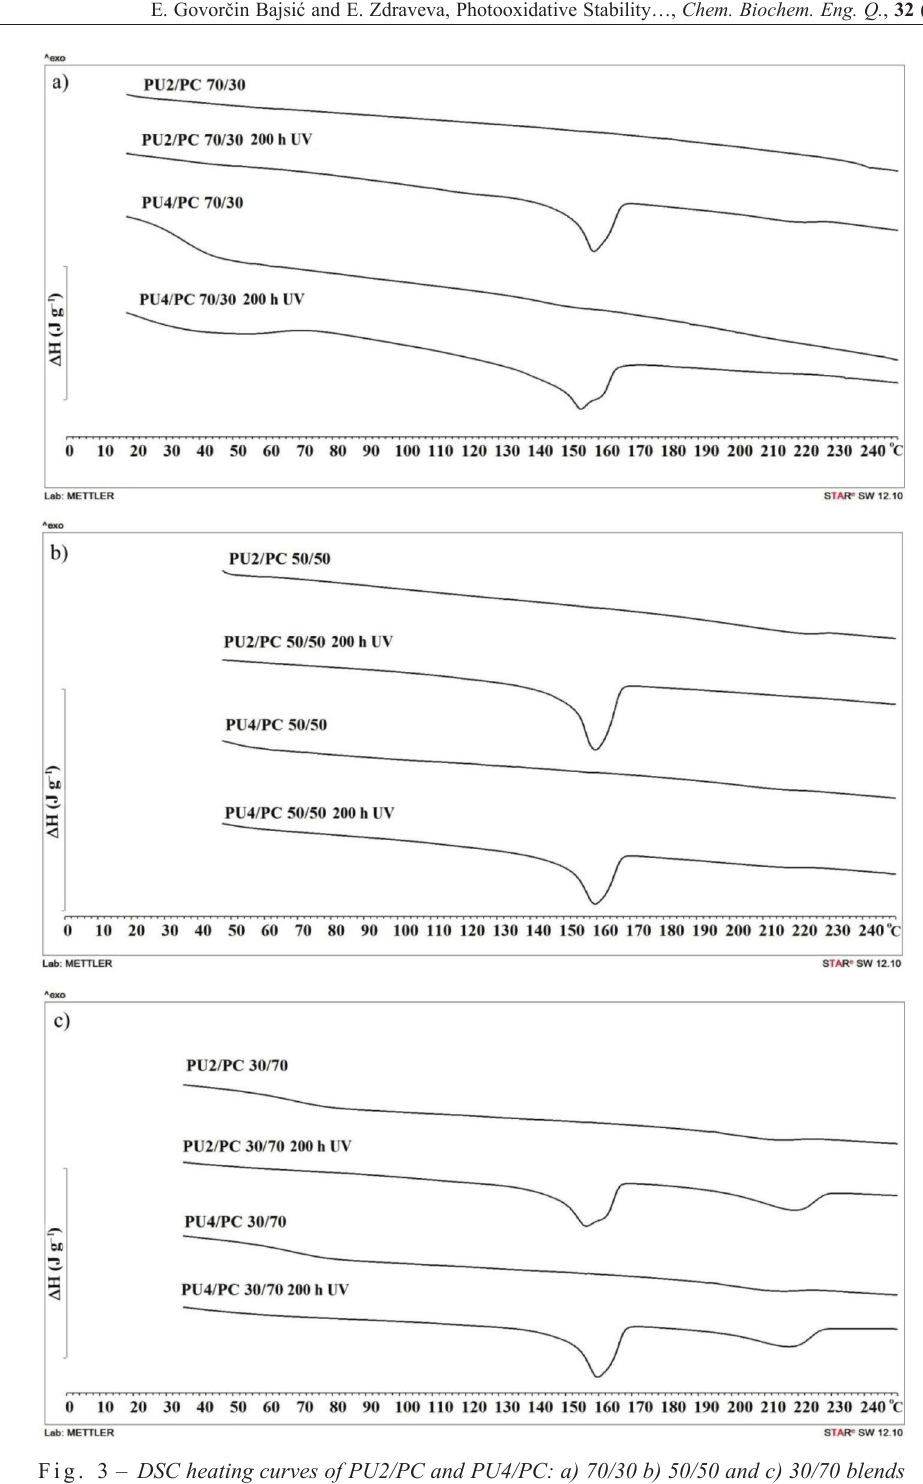
Fig. 3 – DSc heating curves of Pu2/Pc and Pu4/Pc: a) 70/30 b) 50/50 and c) 30/70 blends before and after UV irradiation